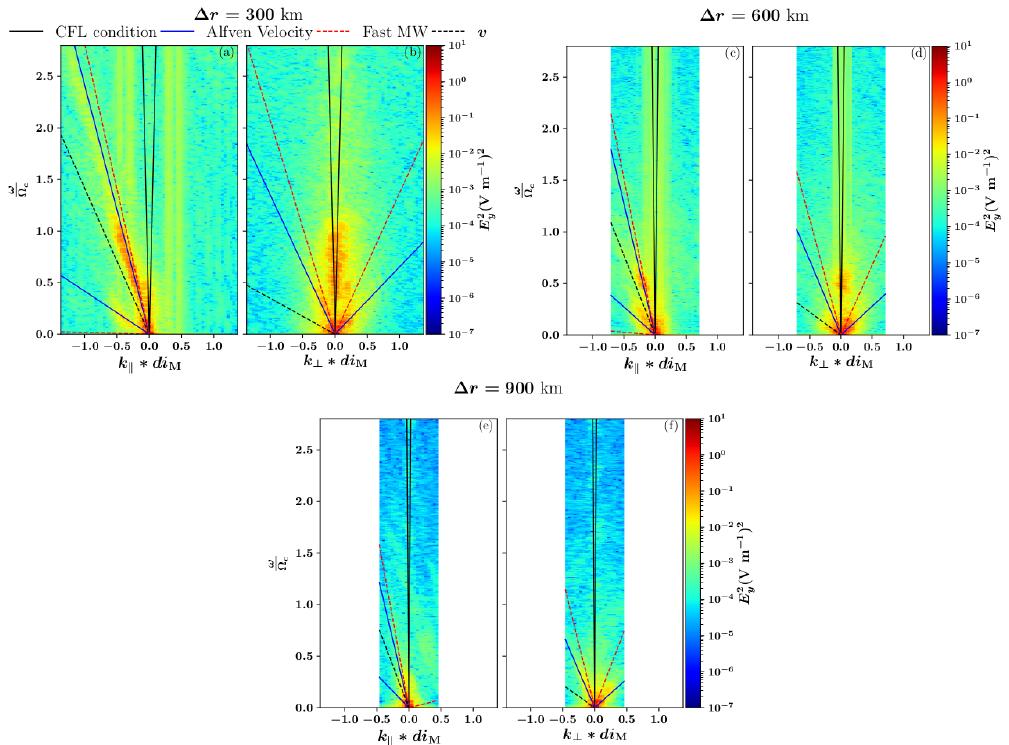
Figure 2. 2D fast Fourier transform of the y component of the electric field in the direction parallel and perpendicular to the background magnetic field, at the location depicted by a red square in Fig. 1. Panels (a) and (b) display the results for the run at a resolution of (cid:49)r = 300km, panels (c) and (d) show the results for the run at a resolution of (cid:49)r = 600km, and panels (e) and (f) show the results for the run at a resolution of (cid:49)r = 900km. The solid black lines represent the Courant–Friedrichs–Lewy condition, the solid blue lines represent the Alfvén speed and the dashed red lines represent the fast magnetosonic speed (labelled MW), with all wave frequencies shown in the simulation frame. The dashed black lines show the Doppler shift due to the plasma bulk